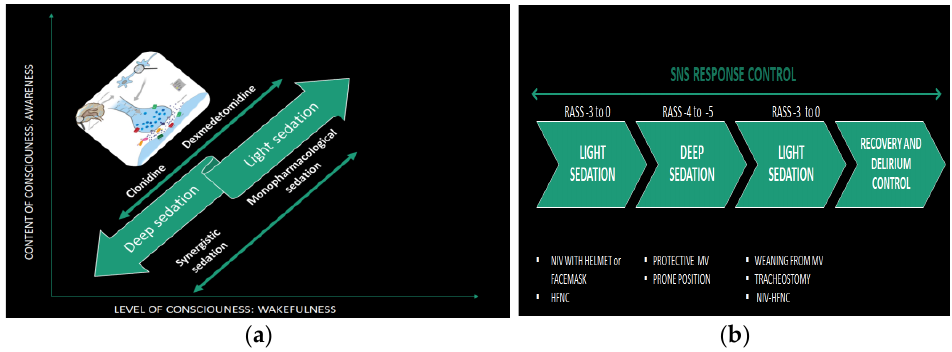
Figure 3. ( a ) α 2 agonists are used throughout different stages of sedation: in deep sedation, clonidine is used with other drugs in synergic sedation; in light sedation, dexmedetomidine is used alone as a monopharmacological sedation ( b ). The aim of the scheme light sedation–deep sedation is the control of sympat hetic nervous system responses for a faster recovery from the intensive care unit with delirium control. The passage from a different sedation scale is in relation to the severity of respiratory failure and types of